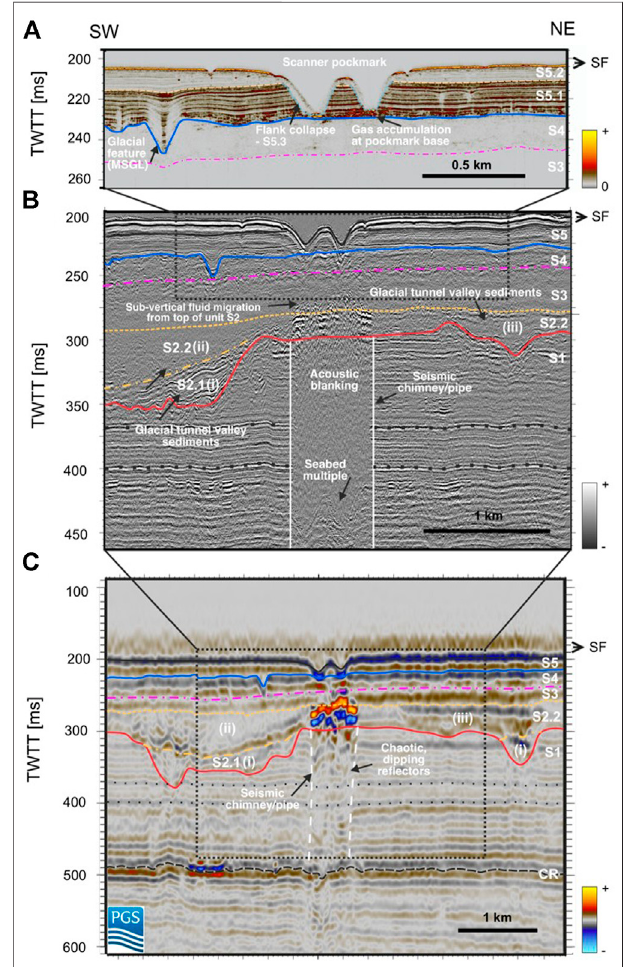
FIGURE 5 | Seismostratigraphy of the Scanner Pockmark region. The seismic pro fi les extend from southwest to northeast across the Scanner Pockmark Complex. (A) Sub-bottom pro fi ler seismic re fl ection data. (B) 2D seismic re fl ection data acquired using Sparker source. (C) 3D seismic re fl ection data. Interpreted seismic units CR and S1 to S5 are shown. CR - CrenulateRe fl ector(topofNordlandGroup),S1 – AberdeenGroundFm.,S2 – Ling Bank Fm., S3-4 – Coal Pit Fm [S3 – Coal Pit and S4 – Last Glacial Maximum deposits (LGM)], S5 – Witch Ground Fm (S5.1 – Fladen Member, S5.2 – Witch Member, S5.3 - Glen Member). Black dashed line (cid:2) CR; red line (cid:2) top S1; orange dot-dashed line (cid:2) top S2.1; orange dashed line (cid:2) top S2.2; pinkdot-dashedline (cid:2) topS3;blueline (cid:2) topS4;palebrowndashedline (cid:2) top S5.1andblackline (cid:2) topS5.2/SF (cid:2) Sea fl oor.Outlineofachimneyisdisplayed with sub-vertical white dashed line. TWT values here are milliseconds below the sea